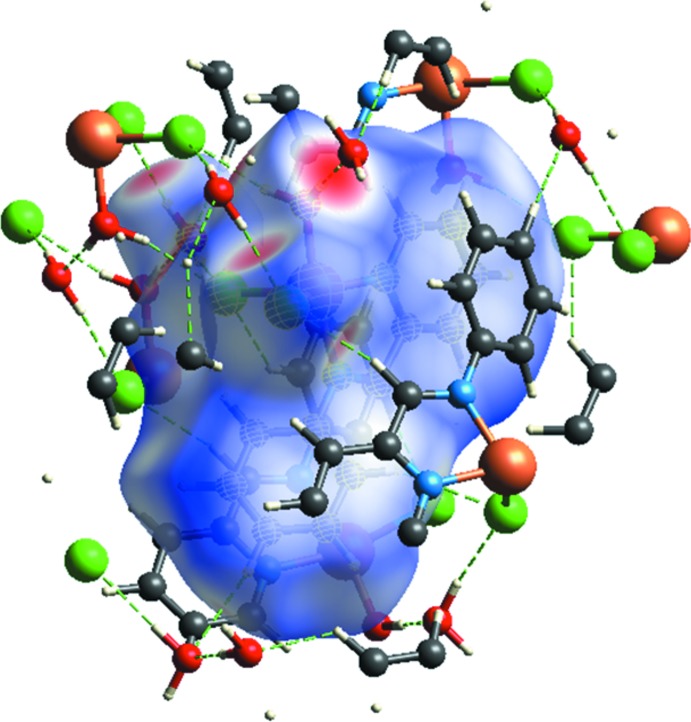
Hirshfeld surface of the title complex mapped over electrostatic potential in the range 0.5 to 1.5 atomic units.